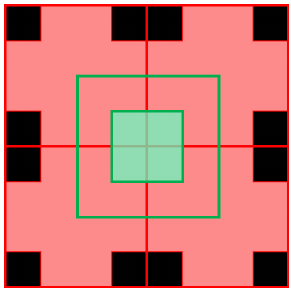
Figure 3. The red and green squares are the two overlapping 4 × 4 pixel patches used to cover the entire image. As the patches overlap, only the highlighted red and the green pixels from the red and green squares are used to estimate the